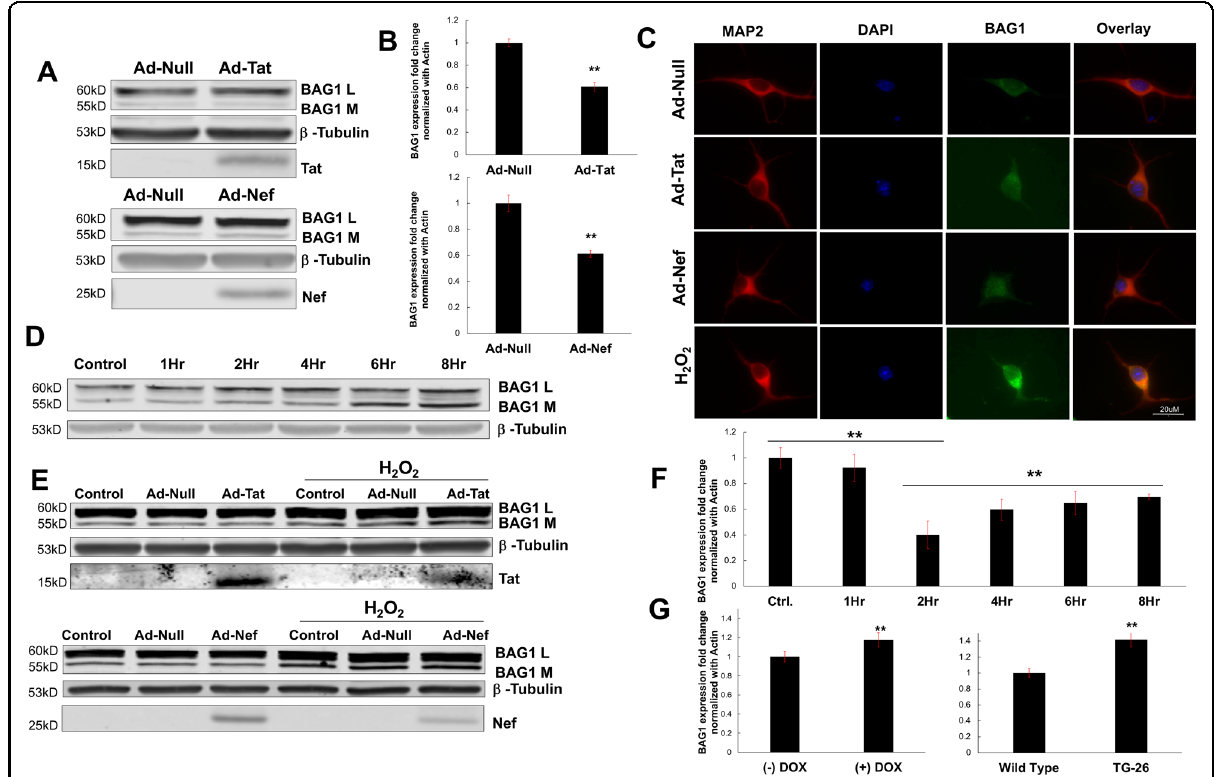
Fig. 3 Compensatory BAG1 regulation. A Western blotting suggested neurons expressing either Tat or Nef did not display altered levels of BAG1 protein in either of its two predominant neuronal isoforms, L or M. B qPCR data suggested each viral protein downregulates levels of BAG1 RNA, despite a lack of alterations at the protein level. C Immunocytochemistry indicated H 2 O 2 induces a compensatory increase in neuronal BAG1 protein. D Western blot results demonstrated such H 2 O 2 -induced increases in BAG1 were dependent on the duration of H 2 O 2 treatment. E Immunoblot analyses illustrated H 2 O 2 treatment in the context of Tat or Nef did not exacerbate the elevation in BAG1 protein. F qPCR data revealed an initial reduction in BAG1 in response to H 2 O 2 ; however, this was followed by a signi fi cant and time-dependent increase. G The H 2 O 2 -induced upregulation of BAG1 was replicated in the frontal cortex of both HIV animal models, with each displaying signi fi cantly increased levels of BAG1 RNA. ** p < 0.01; *** p < 0.001. Scale bar equals 20 μ M; ×60 magni fi